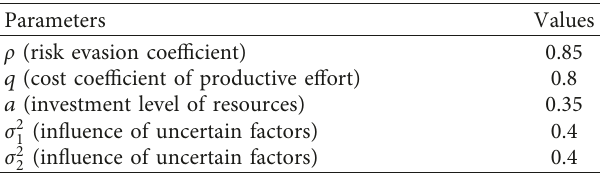
Table 1: Values of relative